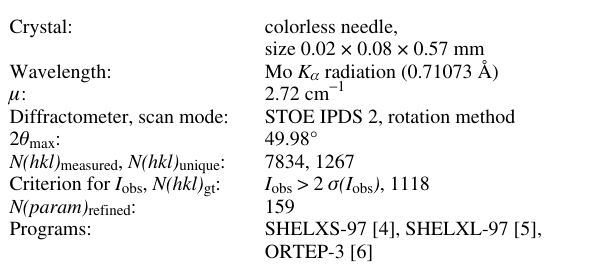
Table 1. Data collection and handling.